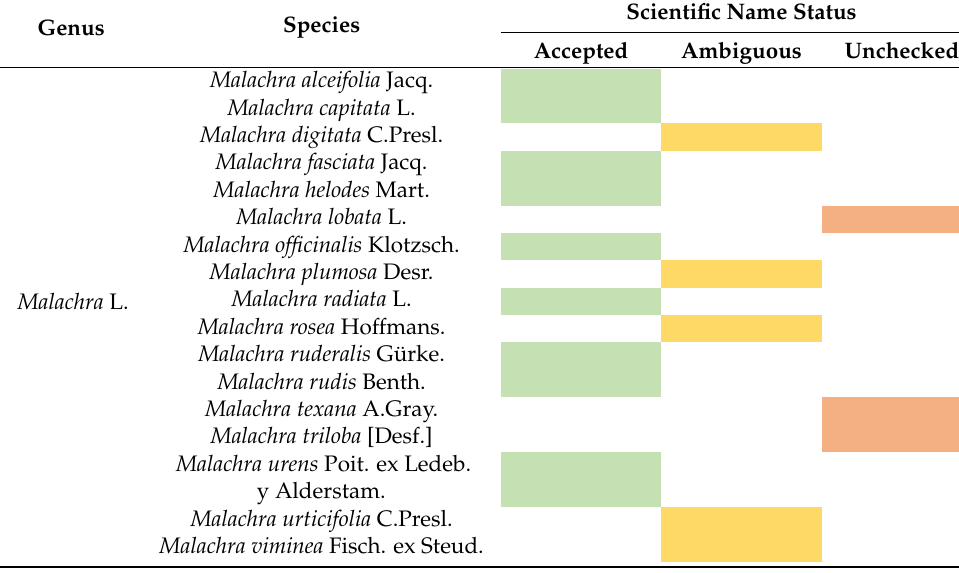
Table 1. Taxonomic name status of species in the genus Malachra L. Genus